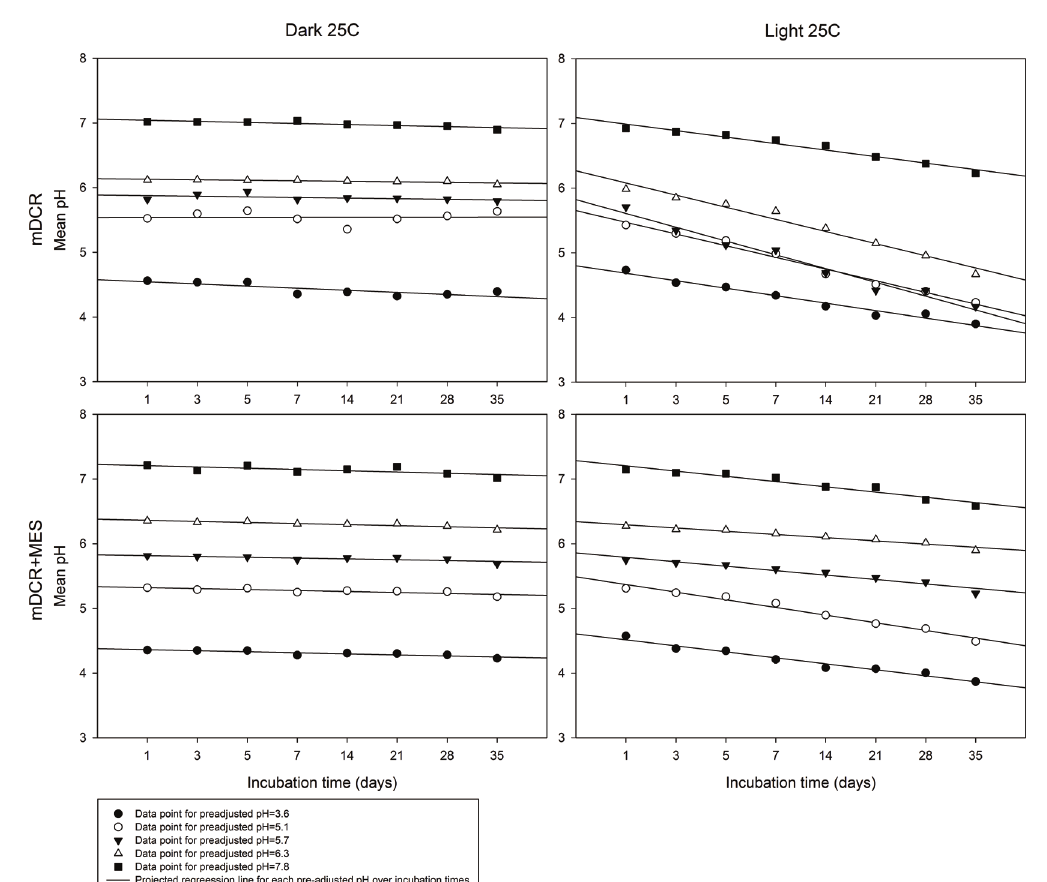
Figure 1. Media pH changes over incubation times from mDCR and mDCR+MES media incubated under dark and light conditions. Medium pH was preadjusted to 3.6, 5.1, 5.7, 6.3, and 7.8 prior to adding 7 g/L of agar, MES and autoclave. Medium was incubated in a growth chamber with full light or darkness at 25 ° C until it reached incubation requirement. Post-autoclaving pH was recorded using a pH meter at each incubation time. Data points represent mean pH (n=5 for each data point), and were fitted with linear regression lines. Please see Dataset 1 for the raw